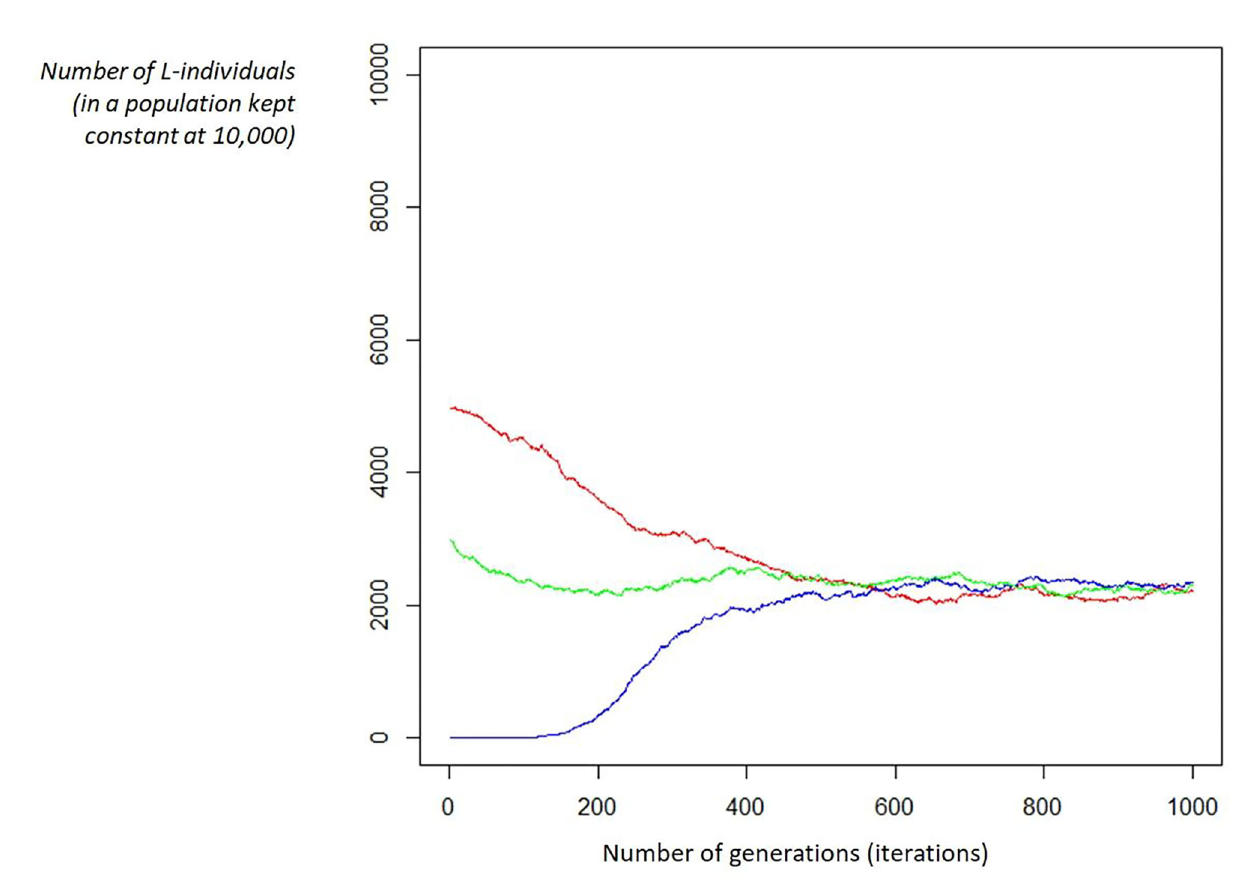
FIGURE1 Examples of convergence. Given the fitness function parameters (e.g., c = 0.9, Ka = 5, Ks = 1) and a fixed population (e.g., 10,000 individuals), the ratio between L/R individuals will converge to the same proportion (ruled by the “c” parameter): in this case, c = 0.9 leads to a proportion of 22% of L-individual, whatever the starting ratio (in the figure, 3 starting ratios are shown: red is L = 50.00%, blue is L = 0.05%, and green is L =